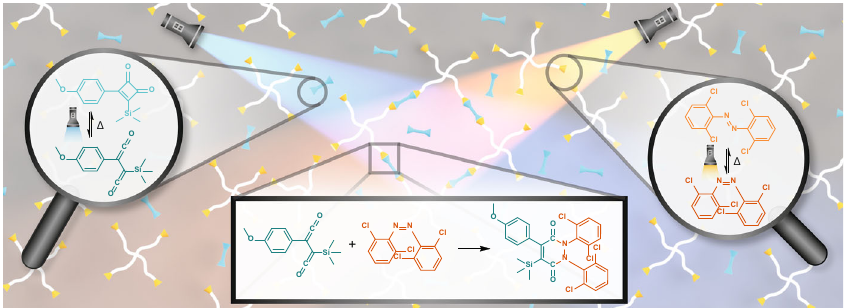
Fig. 1 Schematic reaction overview. Two-colour activation of a stable cyclobutenedione (UV light) and redshifted ortho -substituted tetrachloride azobenzene (orange light) enables formation of ligated product in polymer crosslinking.